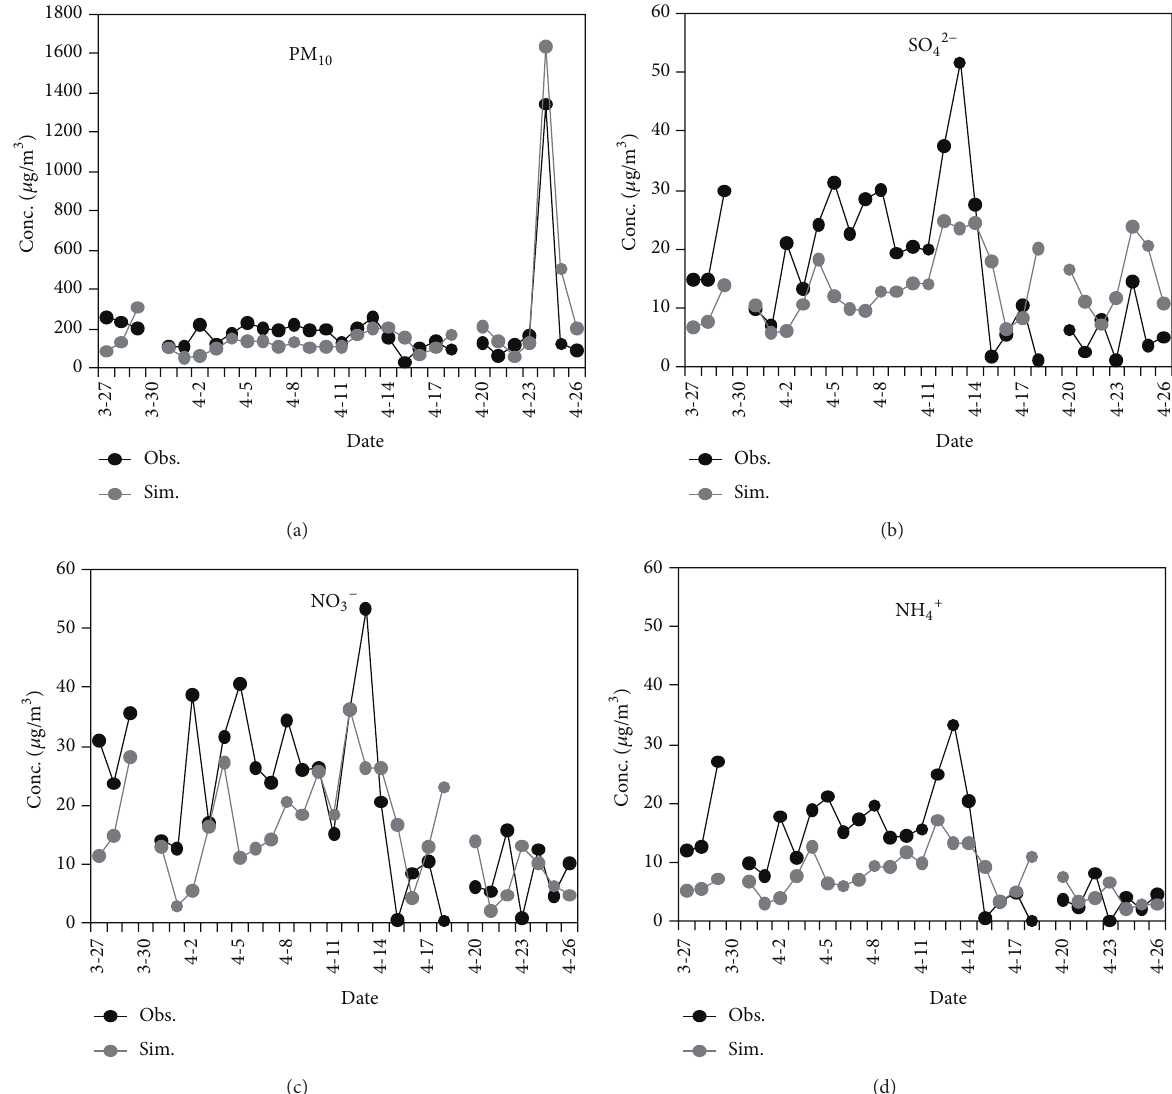
Figure 2: Comparisons between observed and simulated ground-level daily mean concentrations of PM 10 , sulfate (SO 42− ), nitrate (NO 3− ), and ammonium (NH 4+ ) at Mt.